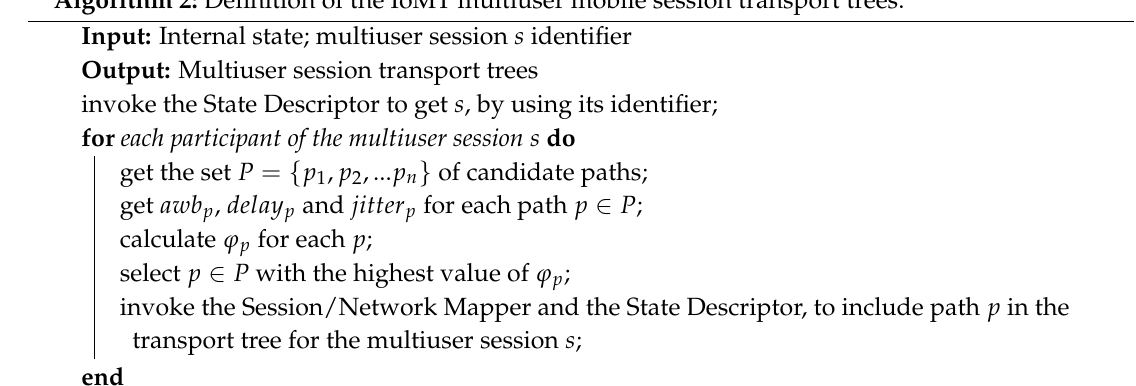
Algorithm 2: Definition of the IoMT multiuser mobile session transport trees.